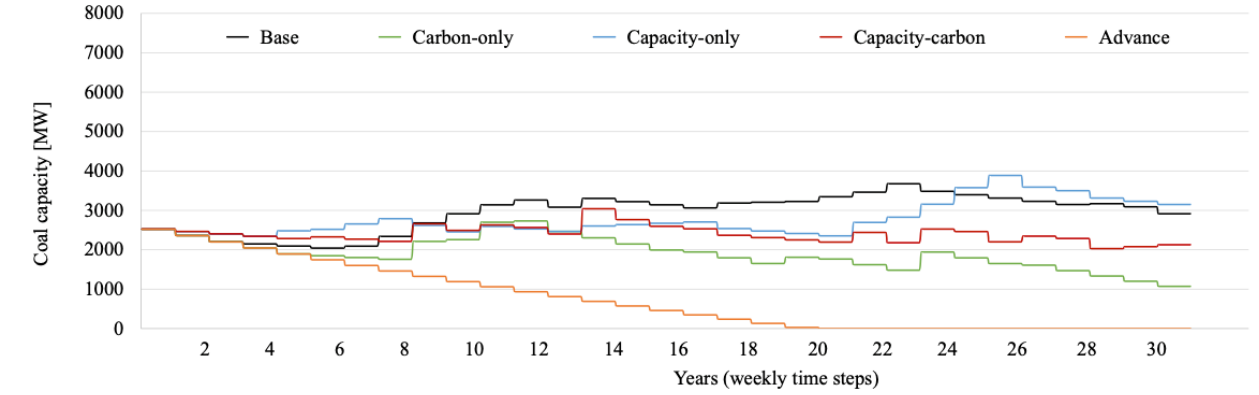
Figure 10. The trajectory of coal power plants ’ capacity